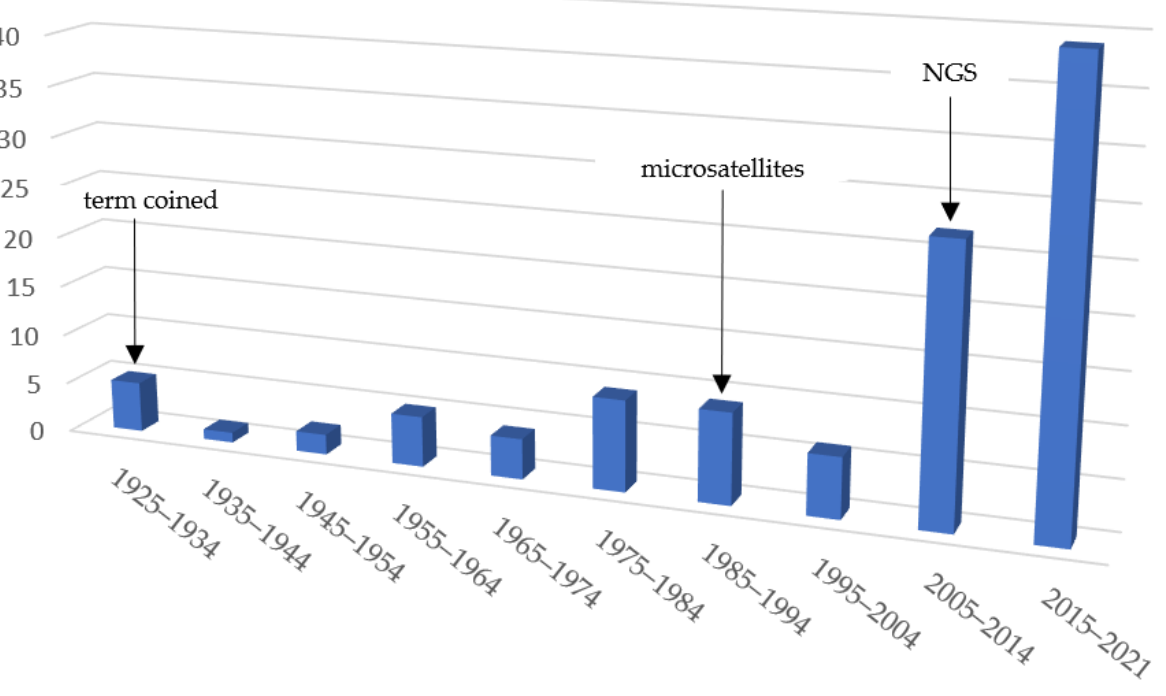
Figure 6. The number of syngameon systems discovered by decade (as of 21 December), showing an increase in the number of discoveries, especially in the 2010s.